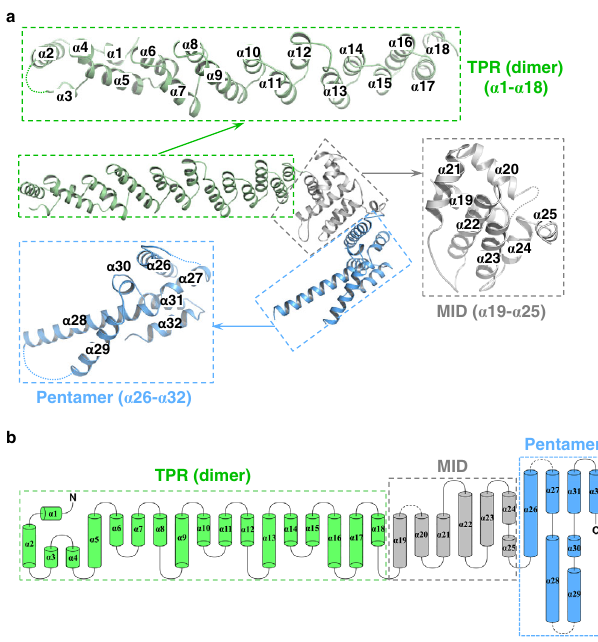
Fig. 2 | Three-dimensional structure of the G5C protomer. a The TPR ( α 1 – α 18), MID region ( α 19 – α 25), and pentamer region ( α 26 – α 32) are shown in green, gray, and blue, respectively. The invisible loop regions are indicated with dashes. b Topology diagram of G5C with secondary structures is colored in the same way as in ( a